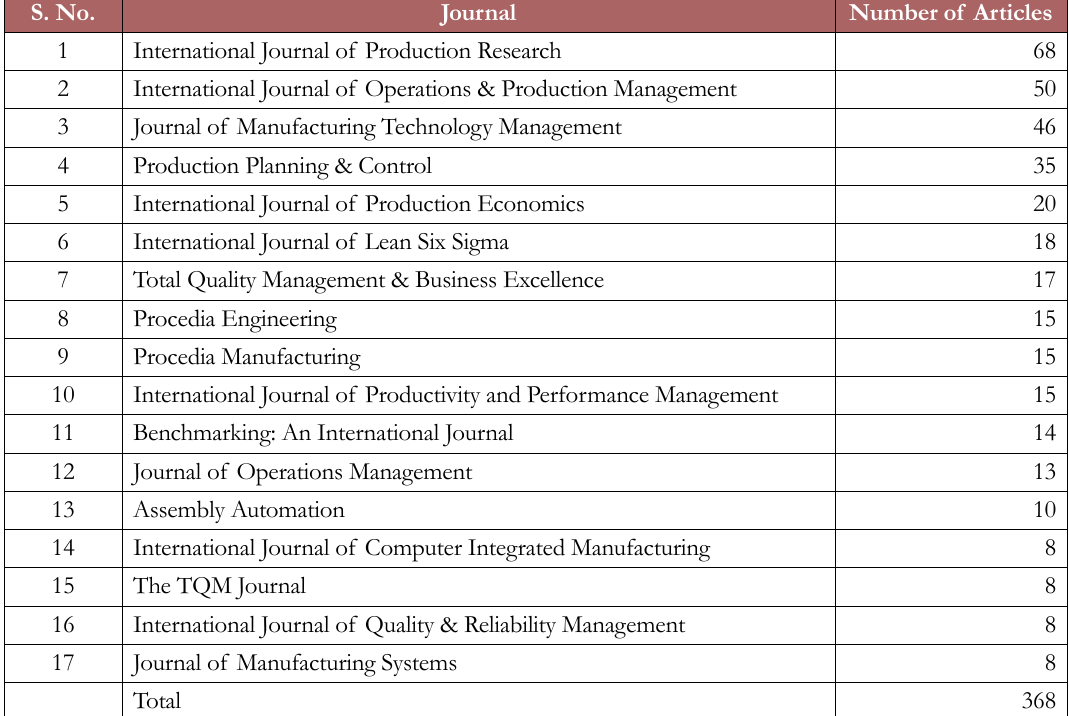
Table 3. Research article in